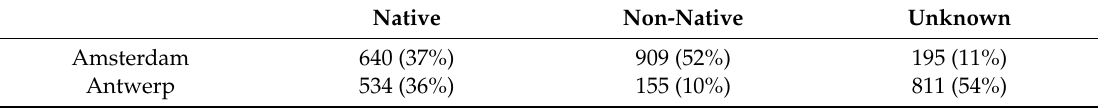
Table 2. Number of painters in Antwerp and Amsterdam according to place of birth, 1600–1700. Native